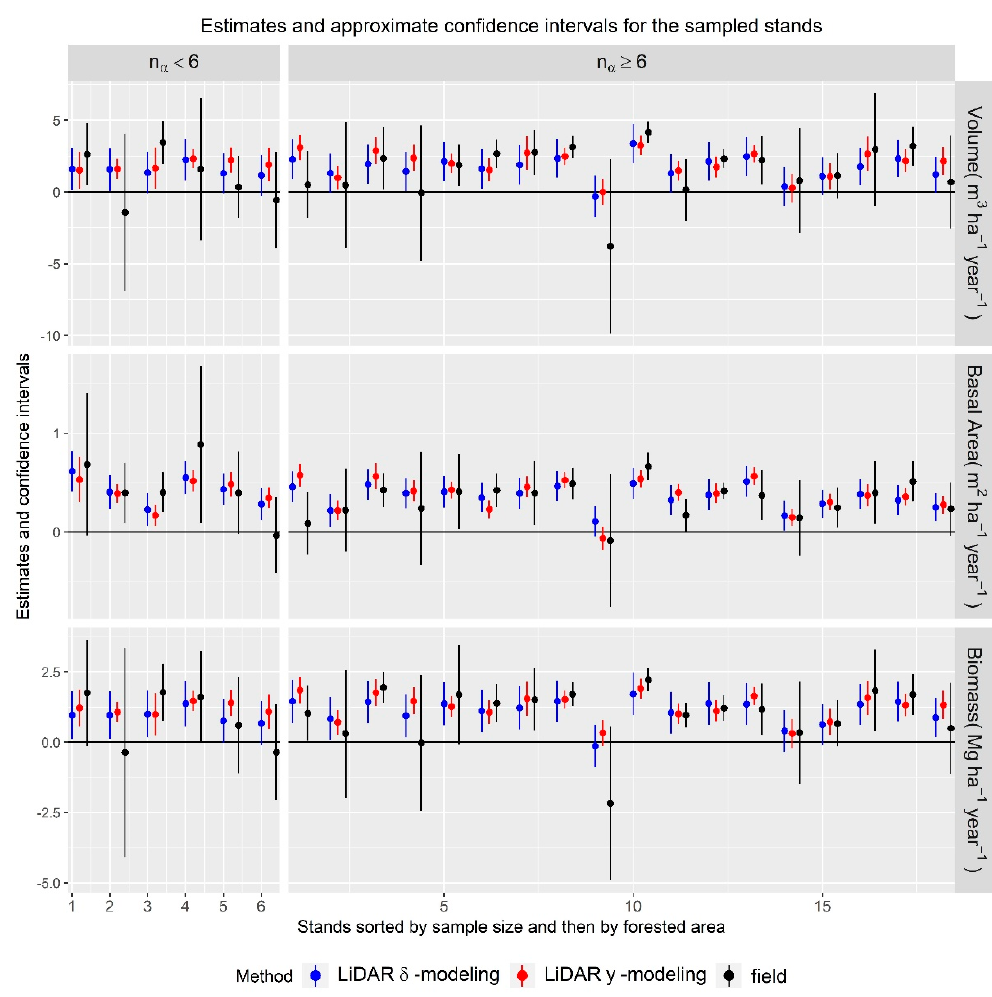
Figure 2. Estimates of V, BA and B change for the sampled stands of Blacks Mountains Experimental Forest. LiDAR-derived estimates using the δ -modeling method are indicated by blue dots, LiDAR-derived estimates obtained using the y -modeling method are indicated with red dots and field-based estimates are indicated using black.